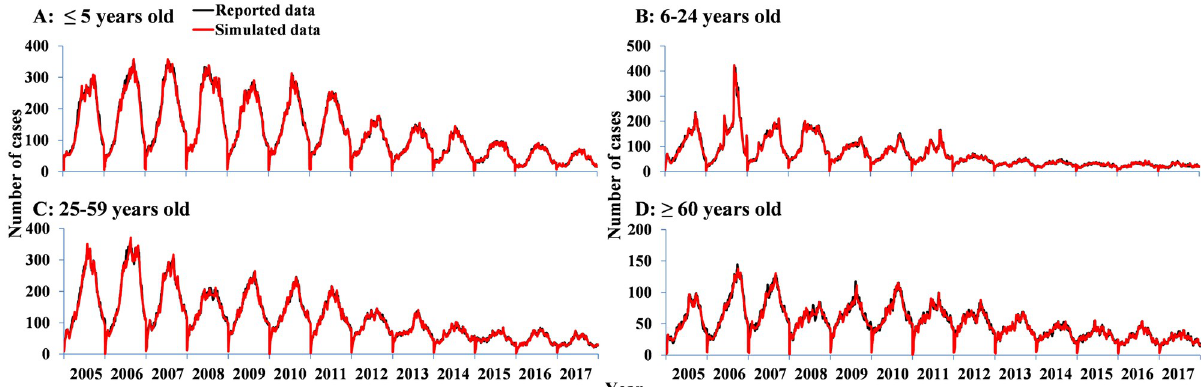
Fig 5. Curve fitting of model to reported data in different age groups from 2005 to 2017 in Hubei. A) � 5 years old. B) 6–24 years old. C) 25–59 years old. D) � 60 years old.